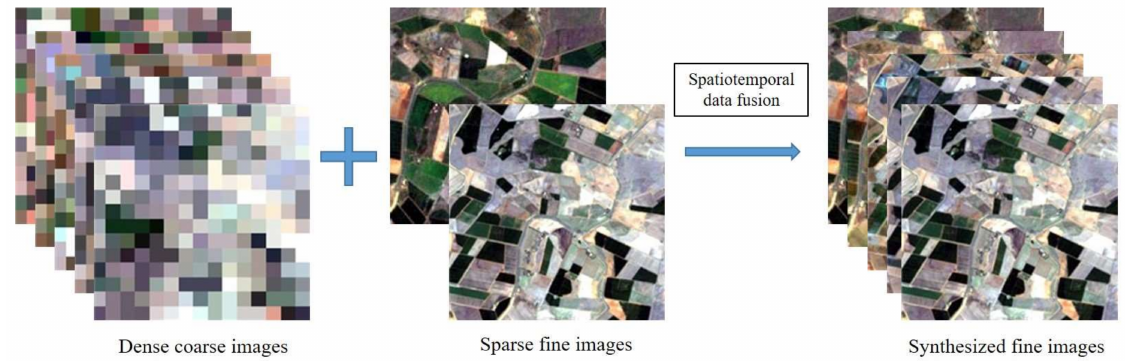
Figure 1. The input and output of spatiotemporal data